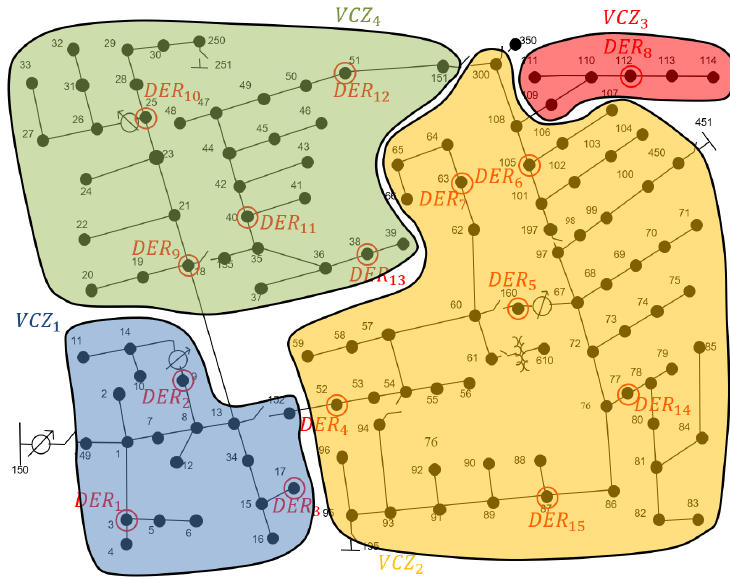
Figure 5. The partition of the IEEE 123-bus system in 4VCZs.